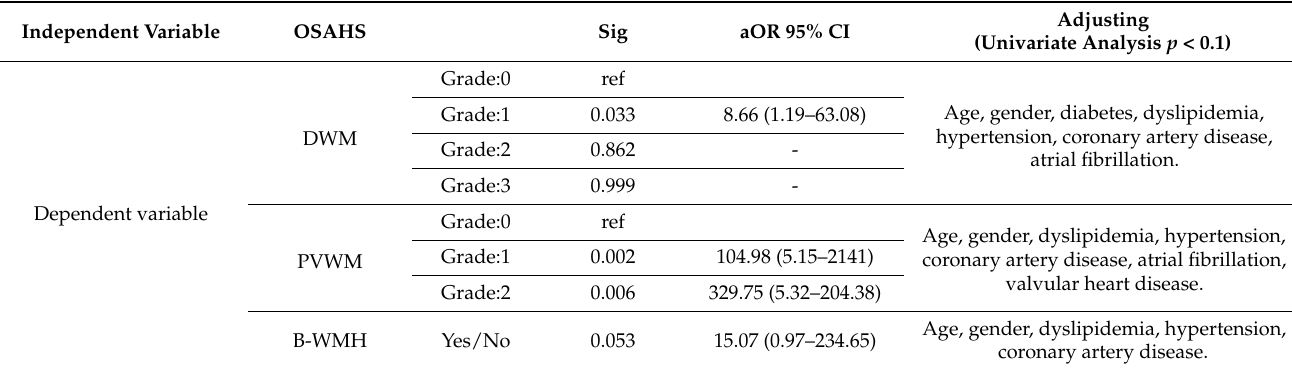
Table 3. Comparison of patients with OSAHS and control group with respect to SVD in the multivariate analysis. Independent Variable OSAHS Sig aOR 95% CI